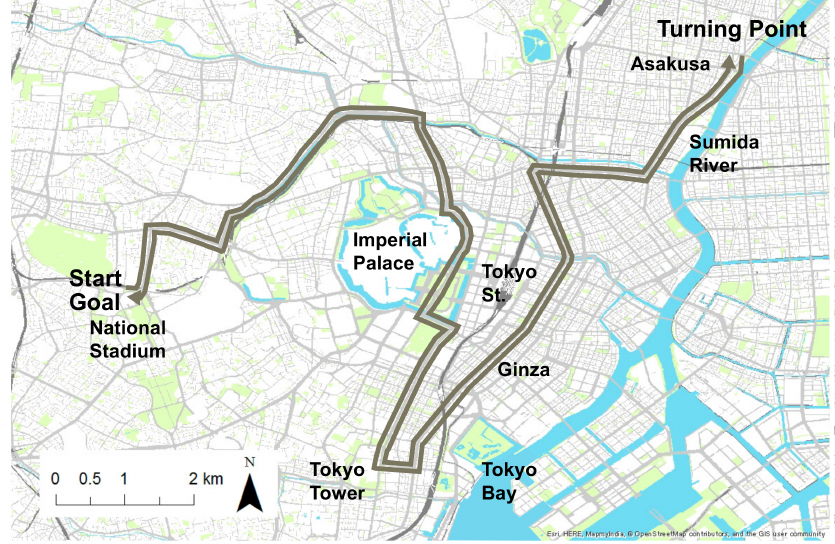
Figure 1. Proposed marathon course for the 2020 Tokyo